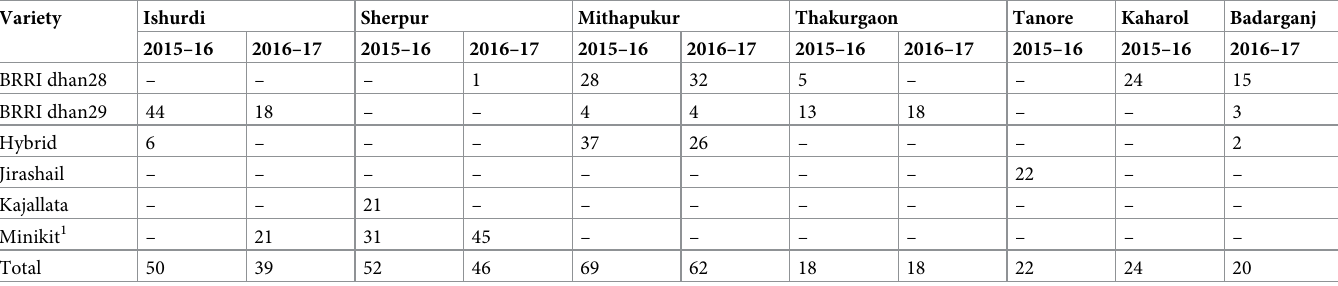
Table 2. Number of fields with different Boro rice varieties at the seven selected sites.